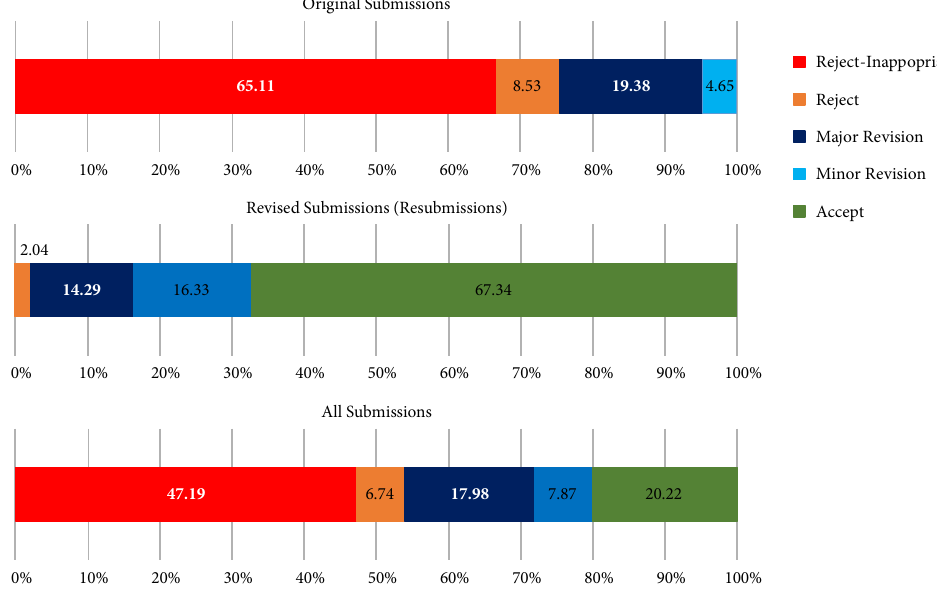
Fig. 3. Decision ratios of the submitted manuscripts in